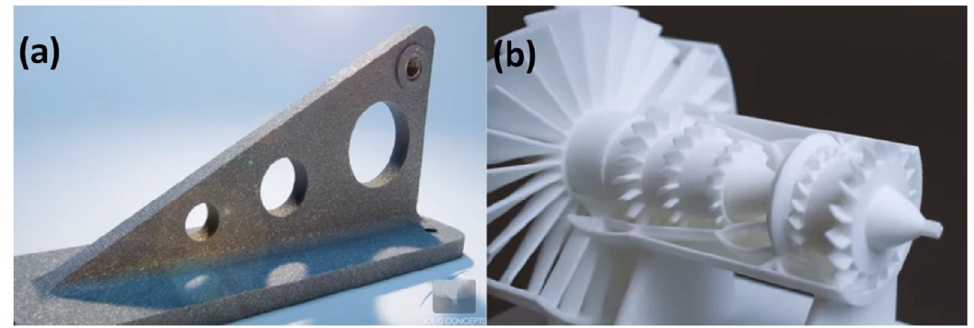
Figure 6. SLS manufactured ( a ) fixture and ( b ) single part turbine.